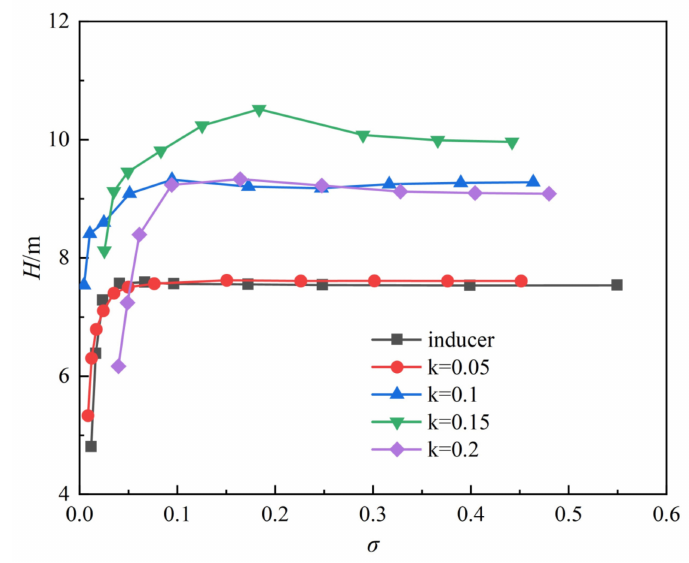
Figure 6. Cavitation performance curves under different radial height.